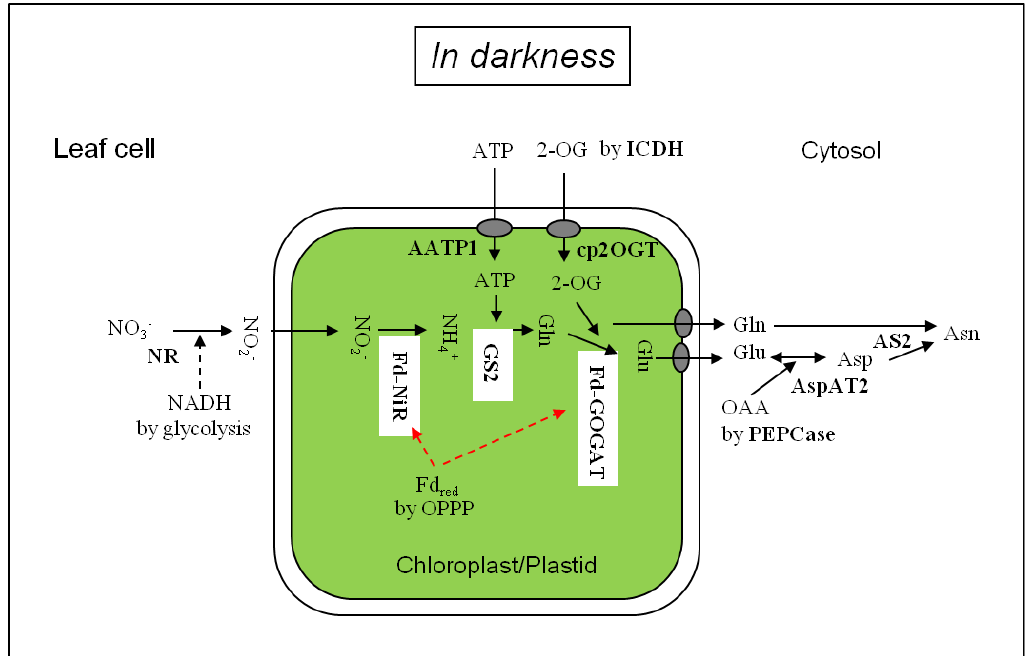
Figure 1. Nitrate and nitrite assimilation in the leaf cells in darkness. AATP1, ATP / ADP transporter; AS, asparagine synthetase; AspAT: aspartate aminotransferase; cp2OGT, chloroplastic 2-OG transporter; Fd red , reduced ferredoxin; Fd-GOGAT, Ferredoxin-dependent glutamate synthase; Fd-NiR, Ferredoxin-dependent nitrite reductase, GS2: chloroplastic glutamine synthetase; ICDH, NADPH-isocitrate dehydrogenase; NR: nitrate reductase; PEPCase, phosphoenolpyruvate carboxylase; OAA, oxaloacetate; OPPP, oxidative pentose phosphate pathway. Ferredoxin-dependent NiR (Fd-NiR), localized in the chloroplasts/plastids [25,27–29], utilizes